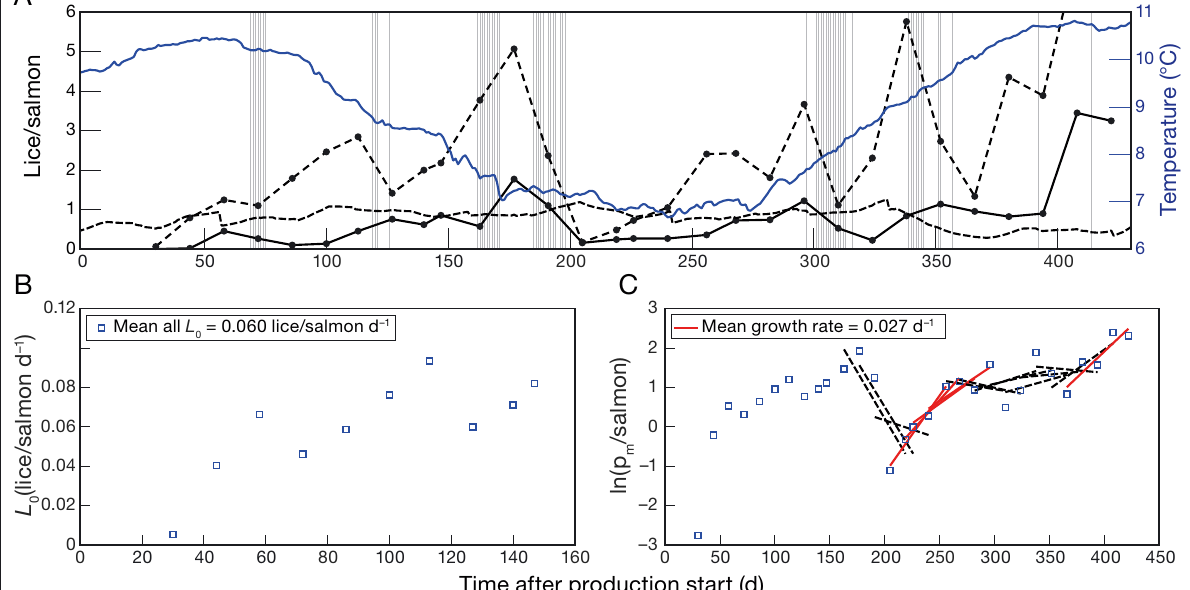
Fig. A1. Example of the calculation of external infection pressure and population growth rate. (A) Gravid and mobile lice shown as solid and dashed lines, respectively. Dashed-dotted line is the mean gravid lice salmon −1 in farm network. Verti- cal lines indicate treatment events and the blue line is temperature. (B) External infection pressure, L 0 , calculated for lice counts before 150 d after sea stocking. (C) Natural log of ρ m , where lines are fitted with 5 consecutive lice counts 150 d after sea stocking. Red lines indicate positive slope and R 2 > 0.6. The mean slope of the red lines in this example is calculated to be 0.27 d –1 . Black dashed lines indicate negative slopes or R 2 <